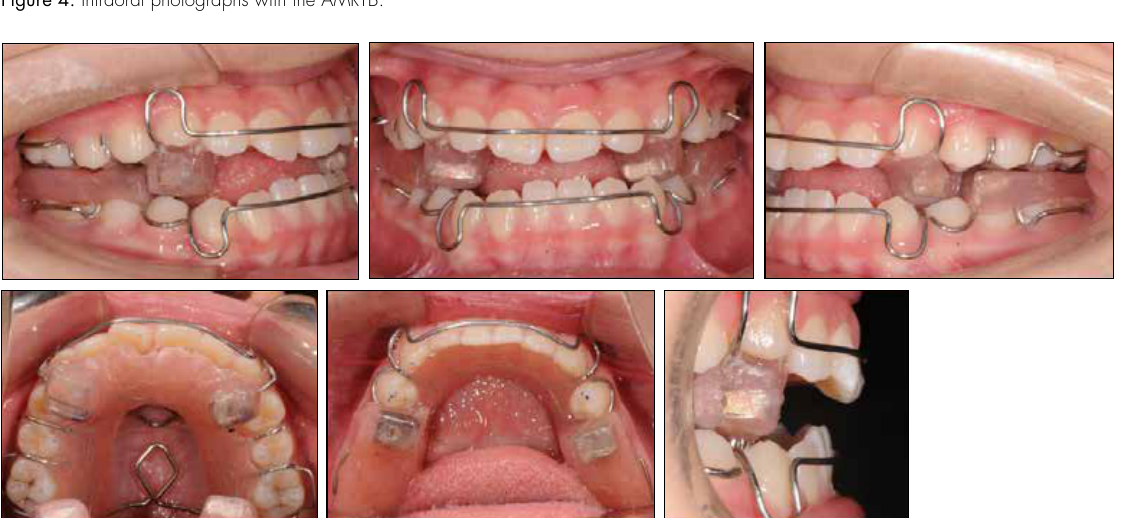
Figure 4. Intraoral photographs with the AMRTB.